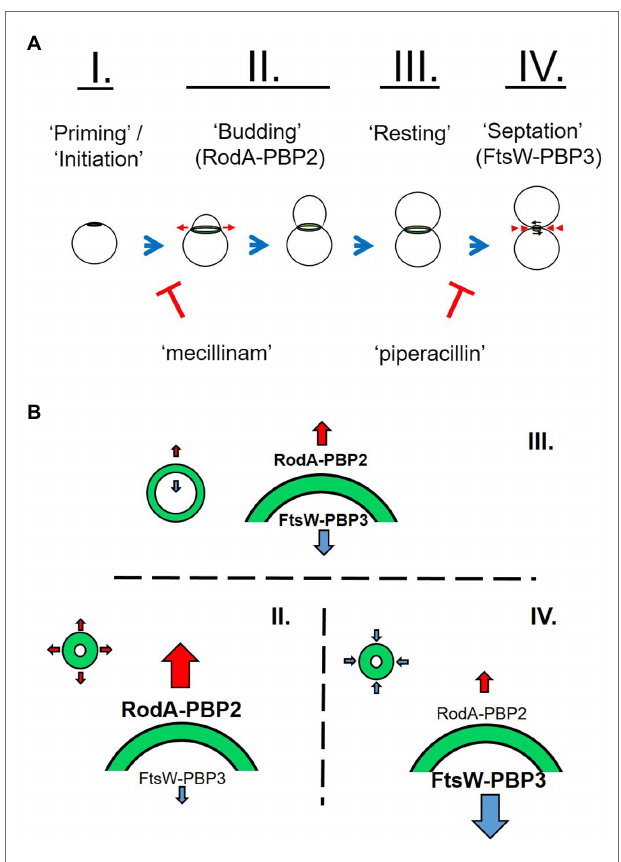
FIGURE 8 | Working model for the role of peptidoglycan in chlamydial polarized cell division. C. trachomatis appears to initiate PG synthesis at a single pole (I.). This polar disk expands outward (red arrows) as a result of MreB-dependent RodA-PBP2 PG polymerization on the disk periphery ( A,B , II.). This coincides with the previously described process of asymmetrical membrane expansion. Due to the transient nature of chlamydial PG in the absence of new synthesis activity, the center of the PG-containing disk degrades, giving rise to a ring-like shape. The ring continues to expand from the outer edge to a point where the rate of PG synthase activity is roughly equivalent to that of PG degradation. This phase of lower intensity PG labeling is the predominant labeling pattern in RBs within C. trachomatis inclusions and is indicative of a resting state between the budding and septation stages of the division process ( A,B , III.). Upon the initiation of septation, the FtsW- PBP3 PG polymerase acts to synthesize PG on the inner edge of the ring, effectively defining the septum as the ring constricts back into a disk, and ultimately dissociates ( A,B ,